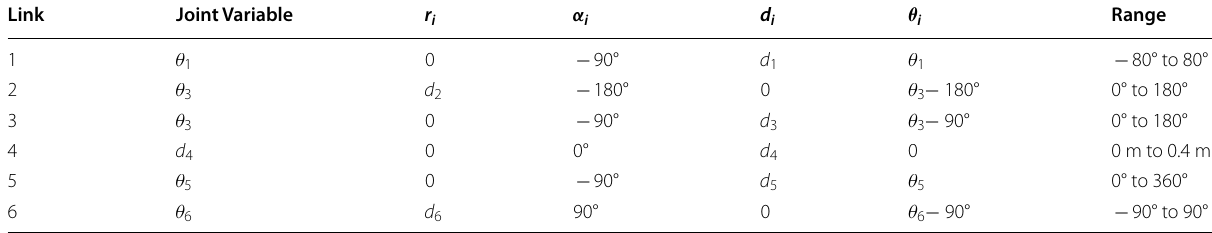
Table 2 D-H parameters of the first six degrees of freedom Link